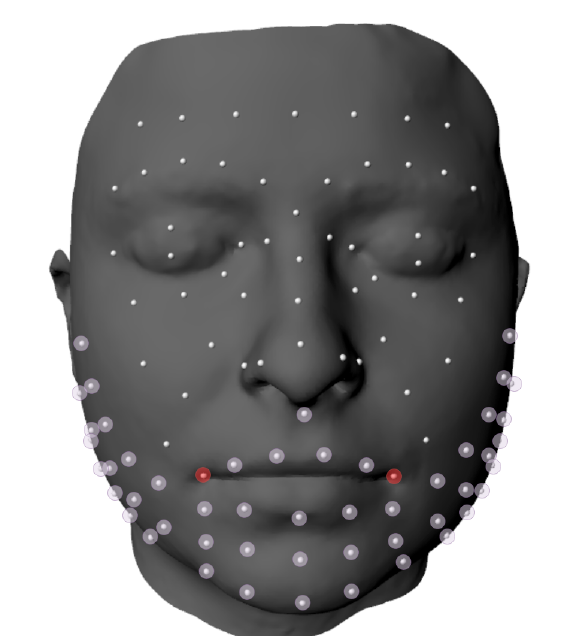
Figure 2. Set of markers virtually placed on a 3D model of the face. The selected markers appear highlighted in violet and red (commissure